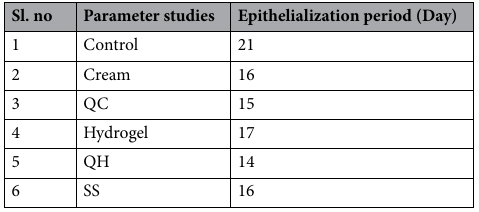
Table 9. Effect of treatments for initiation of